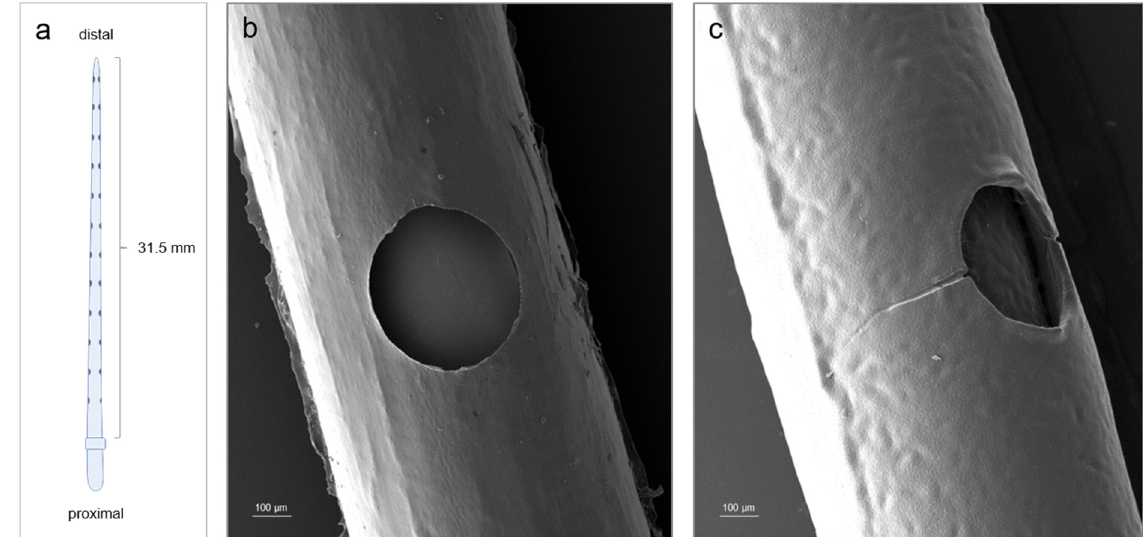
Figure 1. Investigated electrode arrays within this study. ( a ) Schematic illustration of a standard cochlear electrode array (MED-EL). Electrode array insertion part is 31.5 mm long. Ends of the electrode array are distinguished into proximal and distal ends. ( b , c ) SEM images of the fifth platinum electrode contact (hole, counted from distal to proximal end) and the surrounding area of the electrode array. ( b ) SEM image of an uncoated standard cochlear electrode array (MED-EL). ( c ) SEM image of a PLLA-coated standard cochlear electrode array (MED-EL).